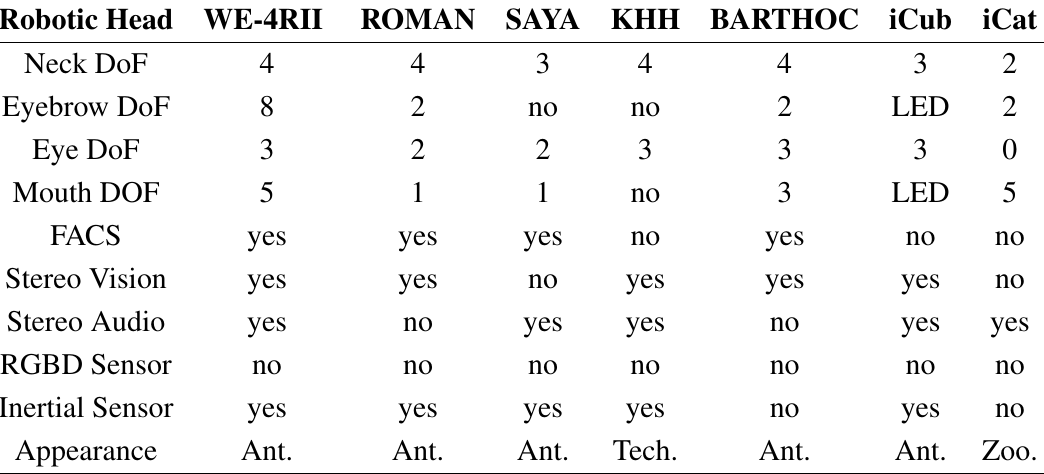
Table 1. Comparison of different robotic heads in the literature (Ant–anthropomorphic; Tech–technomorphic; Zoo–Zoomorphic). FACS, Facial Action Coding